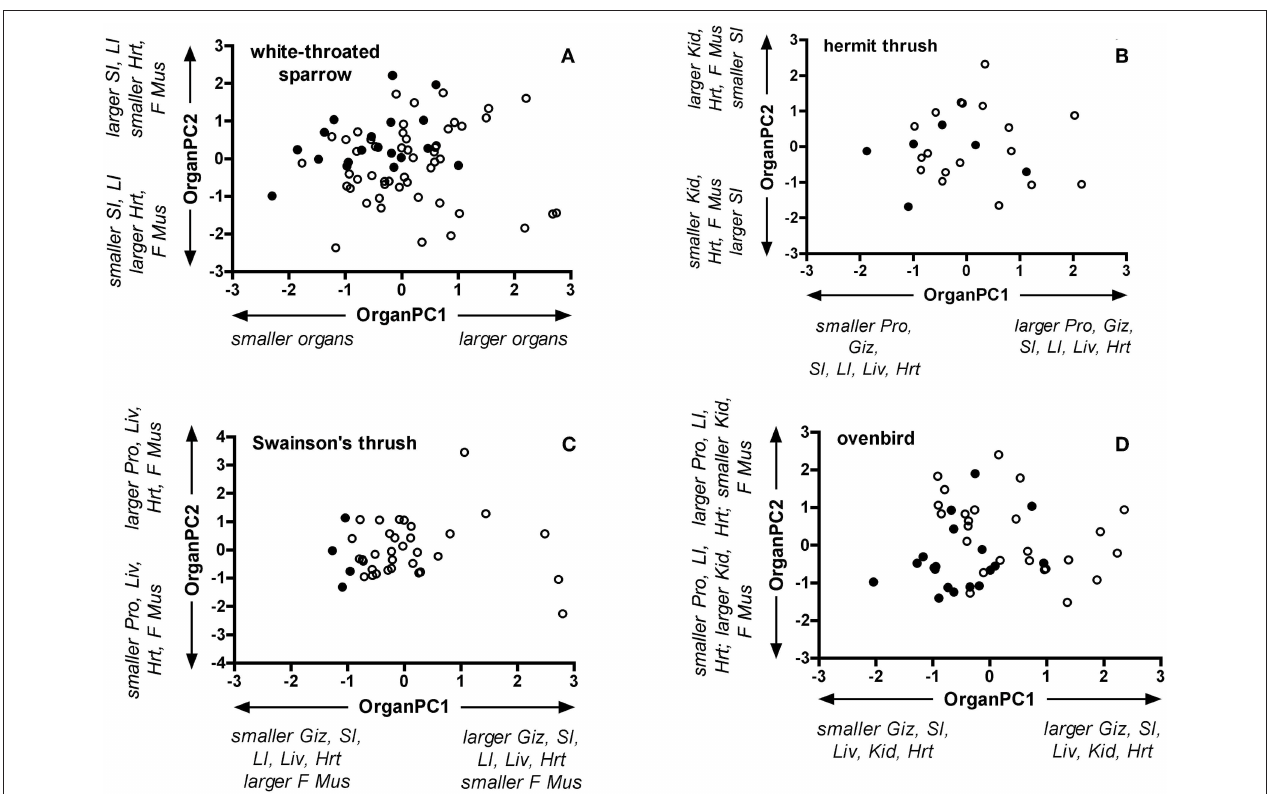
FIGURE 3 | Bi-plots of OrganPC1 and Organ PC2 for adult and juvenile (A) white-throated sparrows, (B) hermit thrushes, (C) Swainson’s thrushes, and (D) ovenbirds. Filled circles represent adults and open circles represent juveniles. OrganPC1 and OrganPC2 are the first and second principal components of separate PCA for each species that included dry masses of the proventriculus, gizzard, small intestine, large intestine, liver, kidney, heart, and flight muscle (pectoralis and